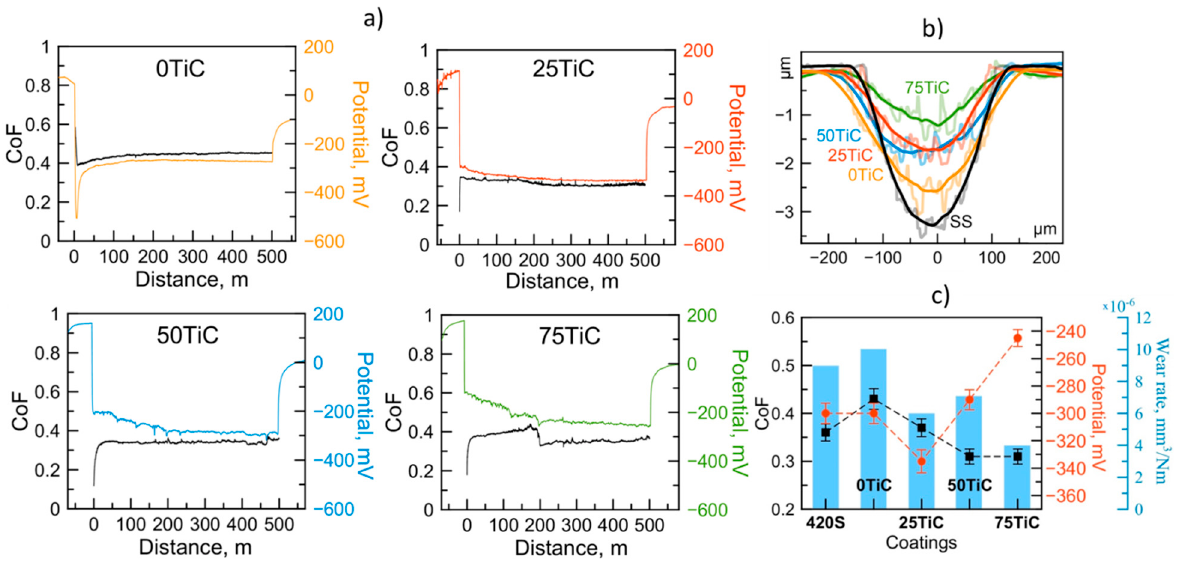
Figure 8. CoF and OCP values vs. distance of tribocorrosion tests in ASW ( a ), corresponding wear tracks profiles ( b ), and a plot summarizing CoF, average wear rates and potential values during tribological tests in ASW ( c ).